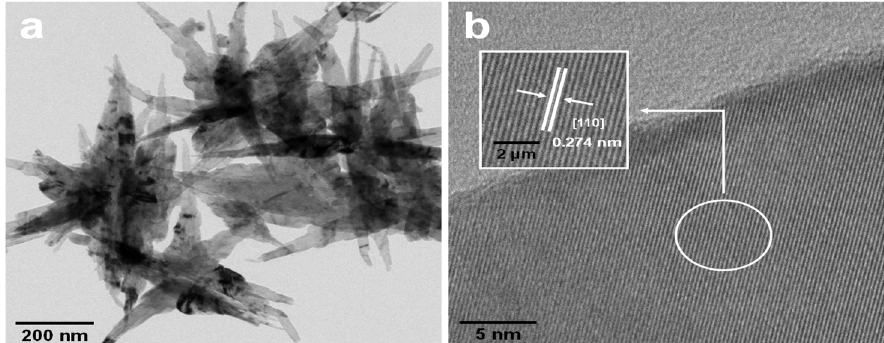
Figure 3. Morphology of CuO NPs: ( a ) TEM image and ( b ) HR-TEM image of CuO NPs.